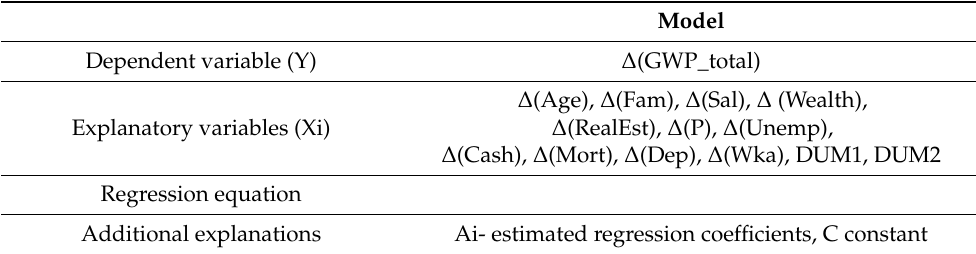
Table 5. Summary of the regression procedure used.